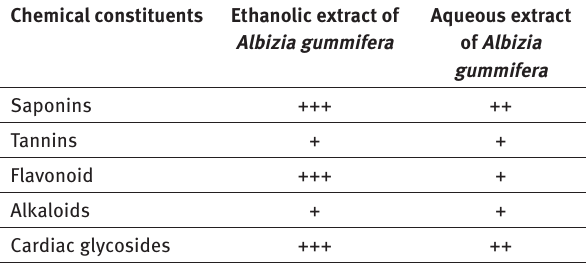
Table 1 Qualitative phytochemistry of ethanolic and aqueous extracts of Albizia gummifera leaf Chemical constituents